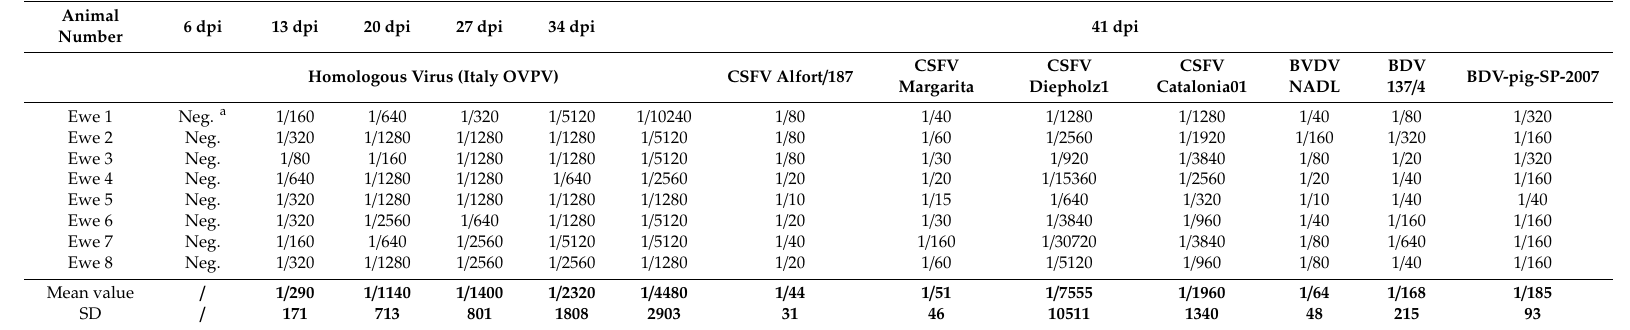
Table 2. Neutralizing antibody titers against homologous and non-homologous viruses from the infected ewes. Animal